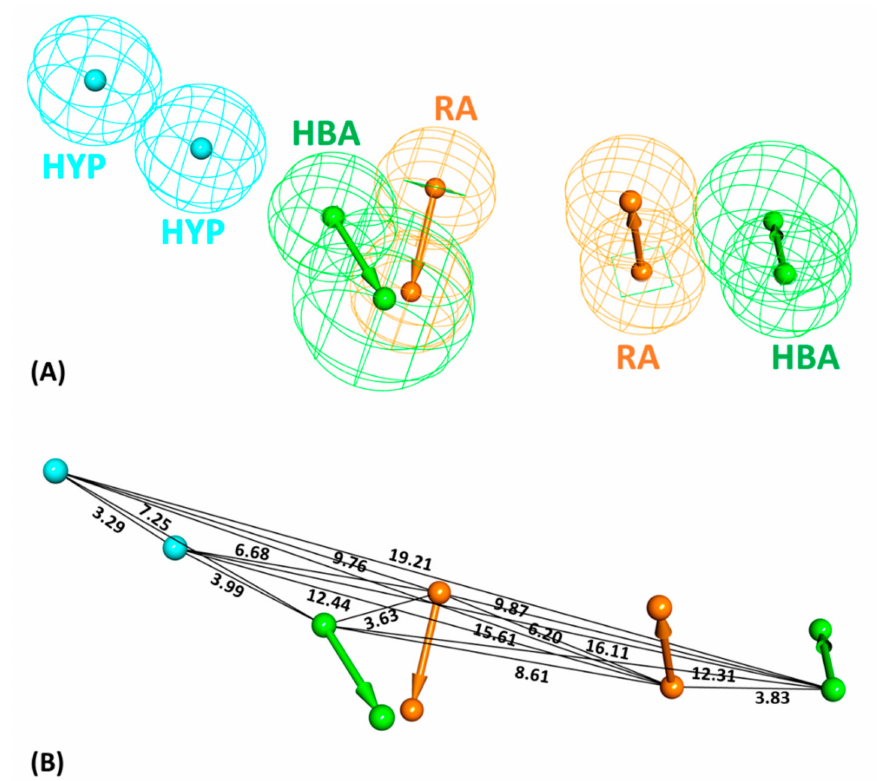
Figure 3. ( A ) The 3D representation of the selected pharmacophore model, Hypo1, containing two hydrophobic (HYP: cyan), two ring aromatic (RA: brown) and two hydrogen bond acceptor (HBA: green) features. ( B ) The interfeature distance (Å) among the features of Hypo1.